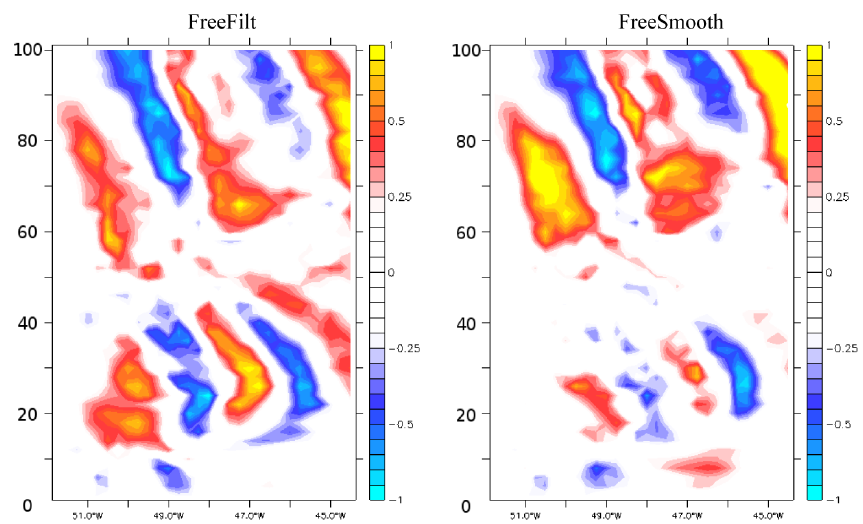
Fig. 7. Evolution of absolute error on velocity (in ms − 1 ), between REF and FreeFilt (left) and FreeSmooth (right). The error is calculated along a section localized at 5 ◦ N, and between 40 ◦ W and 50 ◦ W.